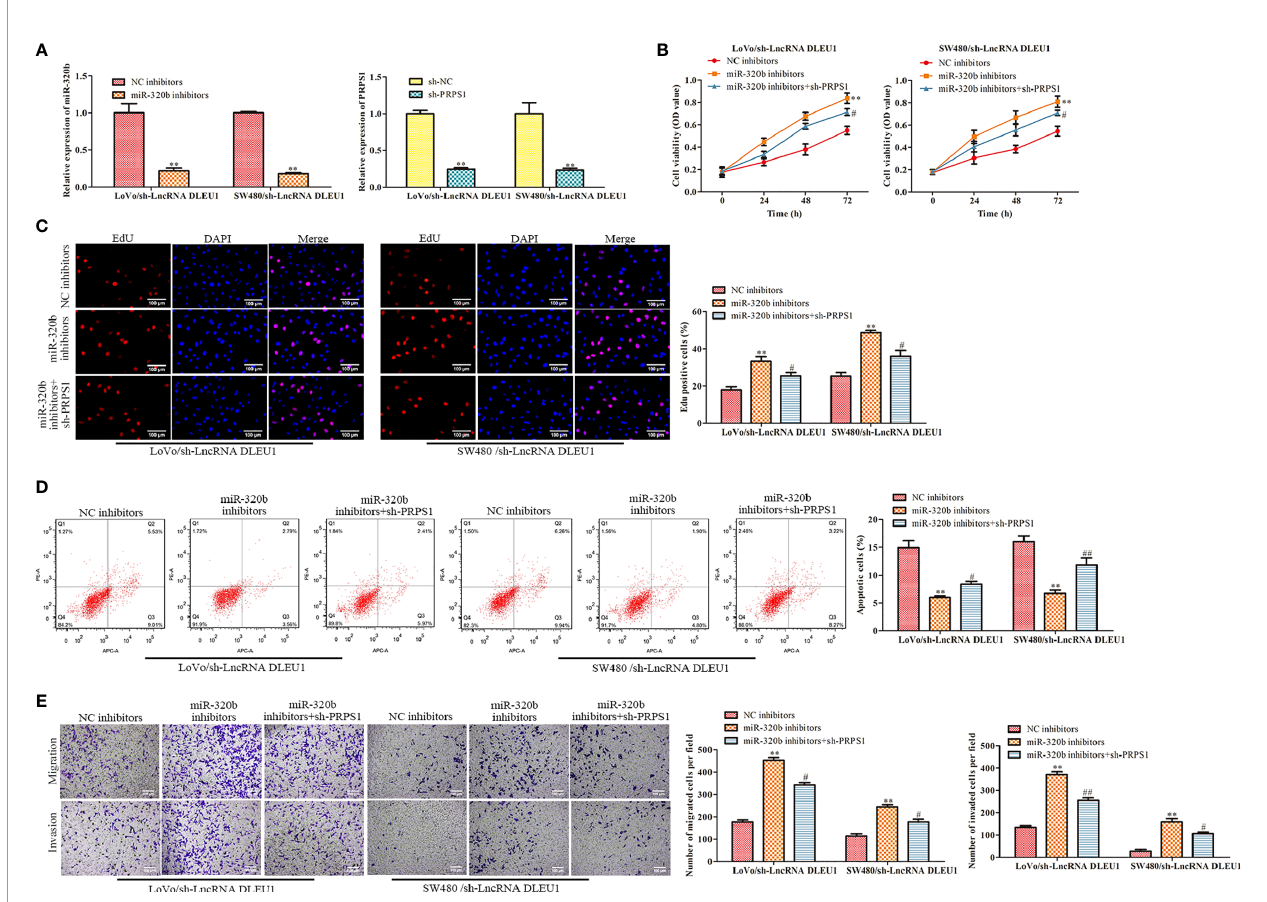
FIGURE 7 | Knockdown of DLEU1 represses cell proliferation, migration and invasion while stimulates cell apoptosis via miR-320b/PRPS1 axis. (A) The relative expression of miR-320b and PRPS1 were determined by qRT-PCR in LoVo and SW480 cells, ** P < 0.01 vs . NC inhibitors or sh-NC. (B) The cell viability was determined using CCK-8 assay in LoVo and SW480 cells, ** P < 0.01 vs . NC inhibitors, # P < 0.05 vs . miR-320b inhibitors. (C) The cell proliferation was determined using EdU assay in LoVo and SW480, ** P < 0.01 vs . NC inhibitors, # P < 0.05 vs . miR-320b inhibitors. (D) The cell apoptosis was determined using fl ow cytometry assay in LoVo and SW480 cells, ** P < 0.01 vs . NC inhibitors, # P < 0.05, ## P < 0.01 vs . miR-320b inhibitors. (E) The cell migration and invasion were determined using transwell assay in LoVo and SW480 cells, ** P < 0.01 vs . NC inhibitors, # P < 0.05, ## P < 0.01 vs . miR-320b